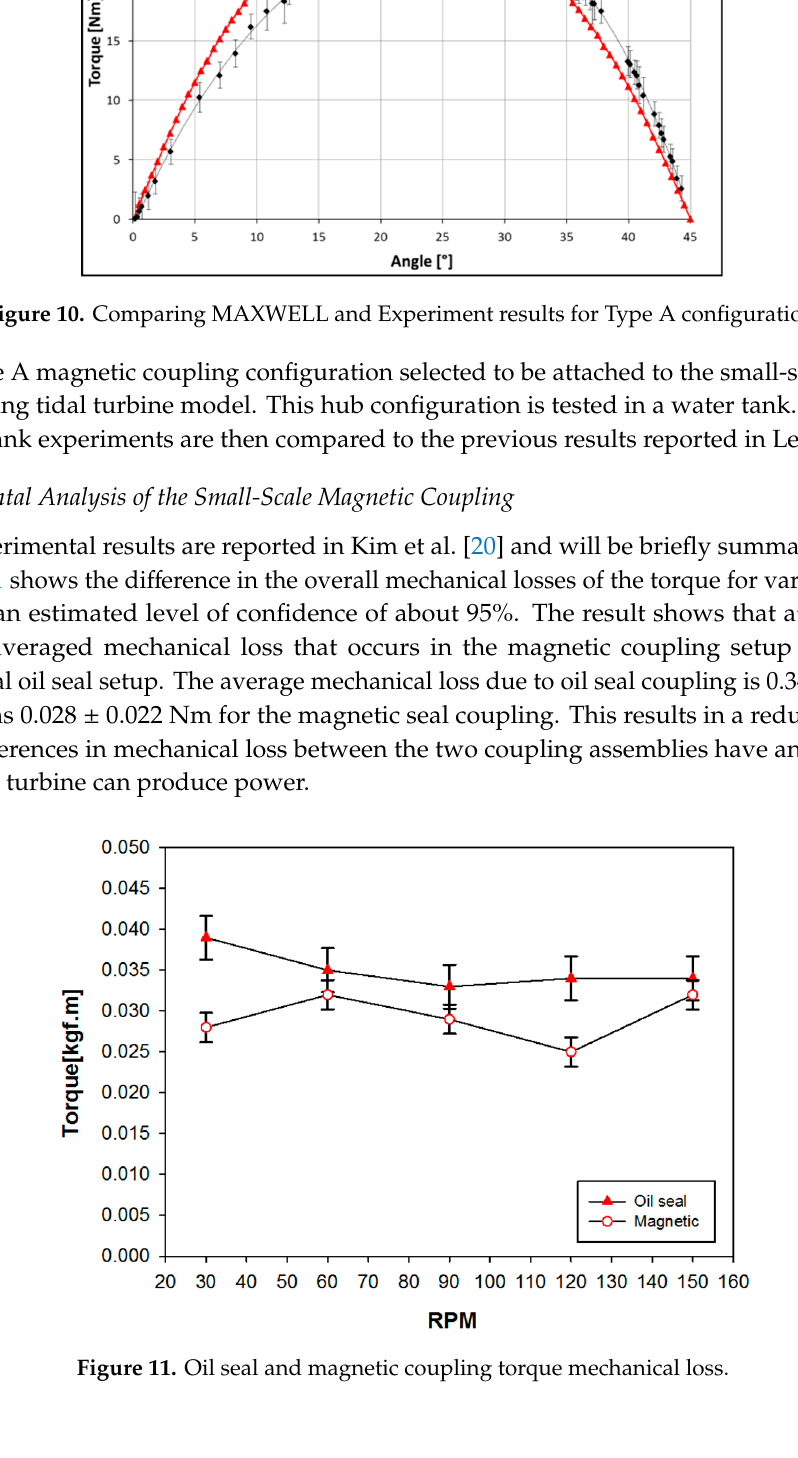
Figure 11. Oil seal and magnetic coupling torque mechanical loss.